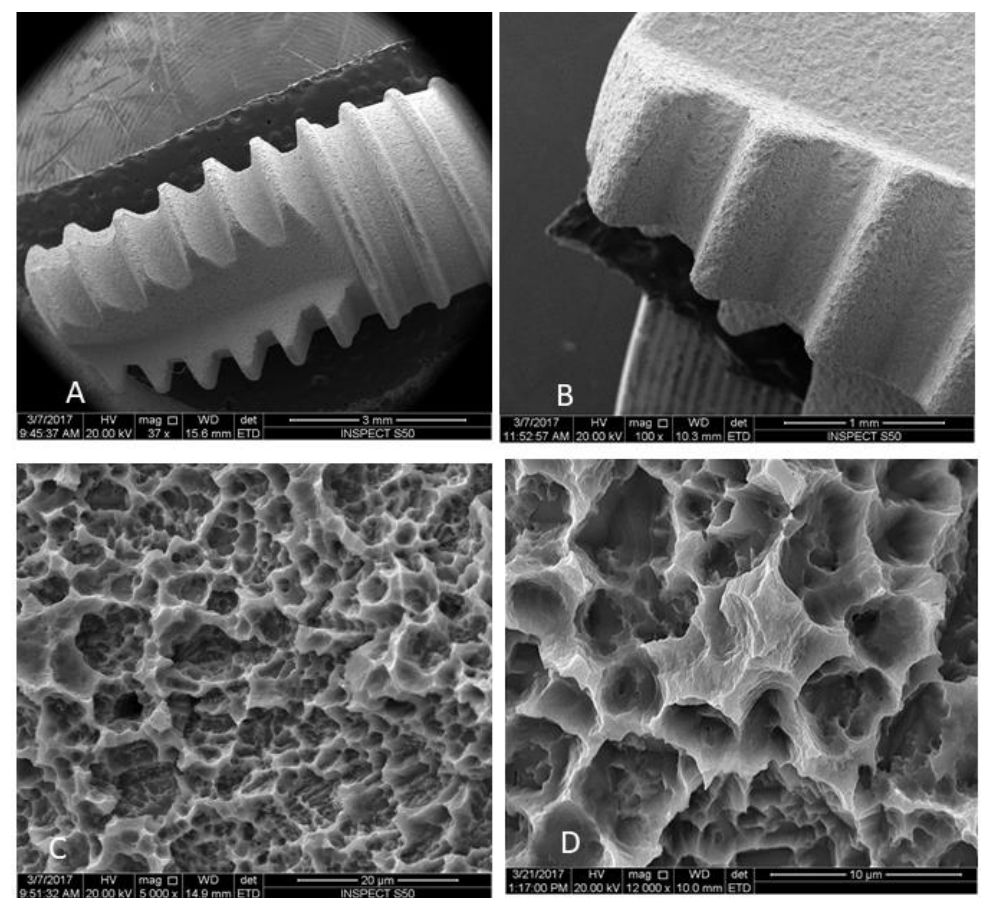
Figure 1. Scanning electron micrographs of MTX implants used in the current study ( A , B ) Higher magnification of the MTX surface before surface contamination: ( C ) 5000 × ; and ( D ) 12,000 ×.